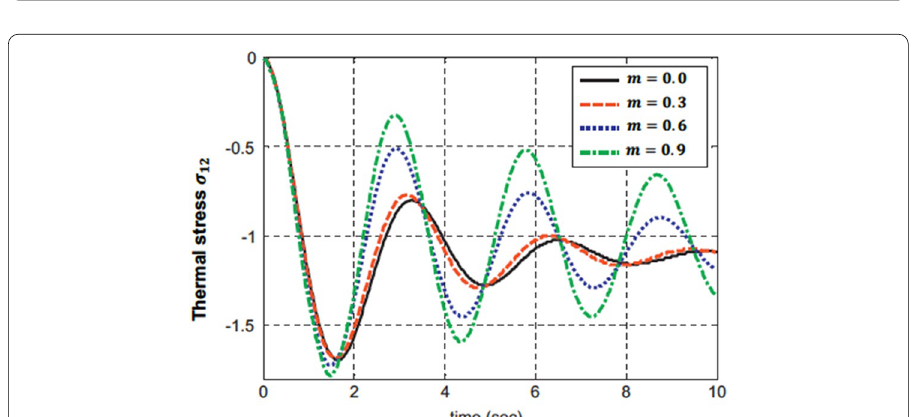
Fig. 7 Variation of the nonlinear thermal stress σ 12 with time τ for different values of functionally graded parameter m